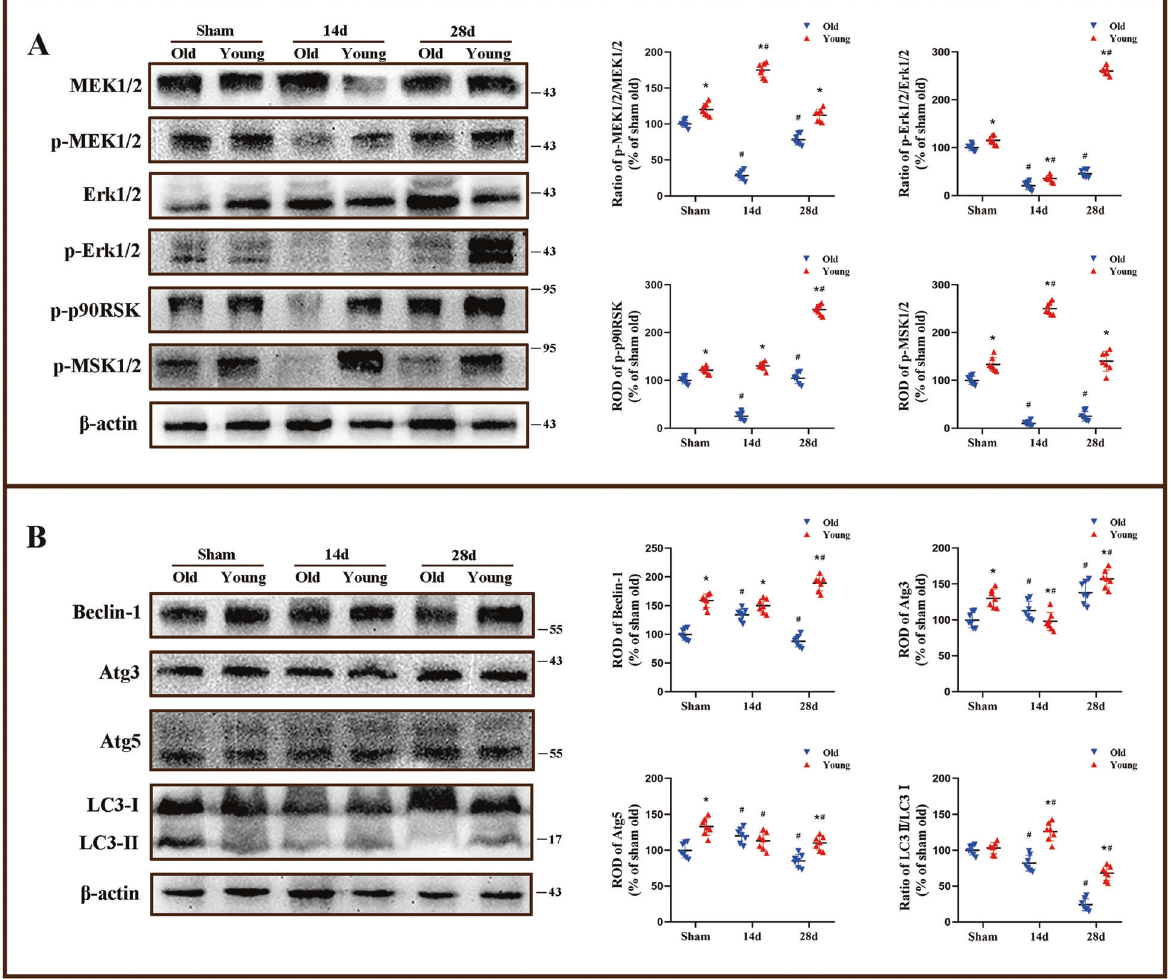
Fig. 3 Observation of Erk1/2 signaling and autophagy-related protein levels. Western blot analysis of p-MEK1/2, MEK1/2, p-Erk1/2, Erk1/2, p-p90RSK and p-MSK1/2 in the hippocampus of the young and old groups after I/R ( A ). Western blot analysis of Beclin-1, LC3-I, LC3-II, Atg3, and Atg5 in the hippocampus of the young and old groups after I/R ( B ) ( n = 7 per group; * p < 0.05, signi fi cantly different from the old group at the same reperfusion time point, # p < 0.05, signi fi cantly different from the sham group of the same age). Bars indicate mean ±